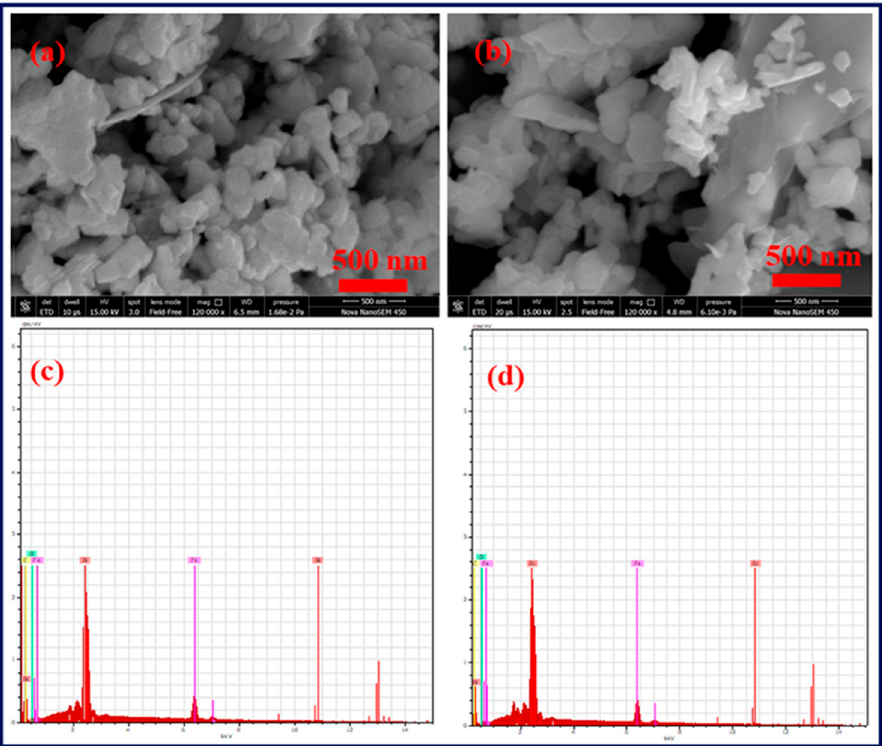
Figure 2. FESEM images of the [BiFe 1 − x Li x O 3 ]-graphene nanocomposite ( a ) x = 0.04 and ( b ) x = 0.06. EDXS Analysis of the [BiFe 1 − x Li x O 3 ]-graphene nanocomposite ( c ) x = 0.04 and ( d ) x = 0.06.